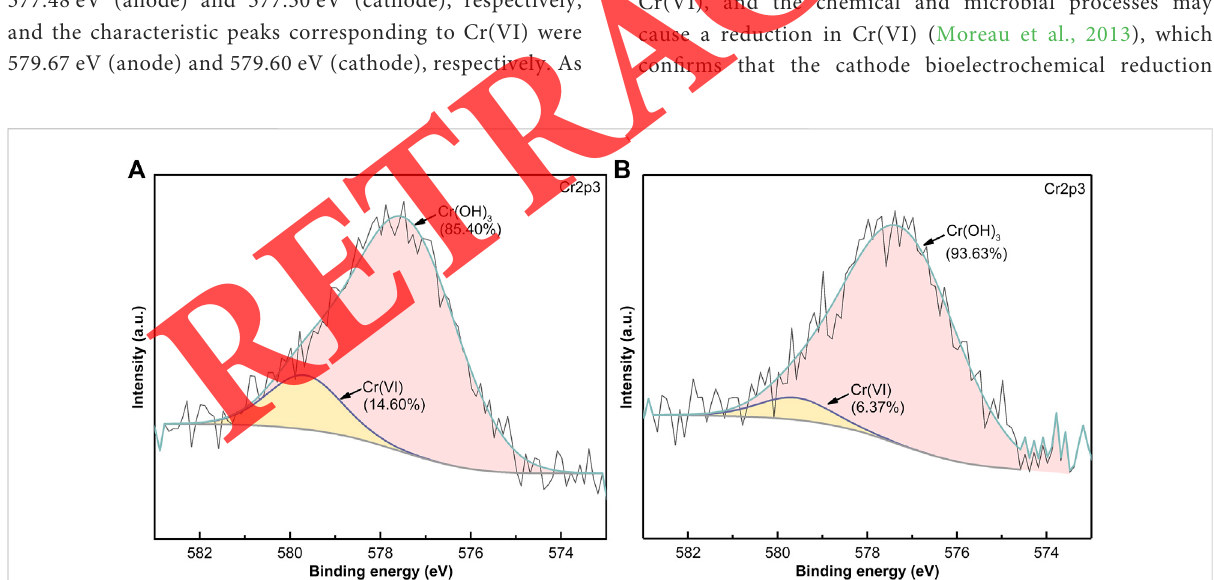
X-ray photoelectron spectroscopy wide scan spectra of the substrates.